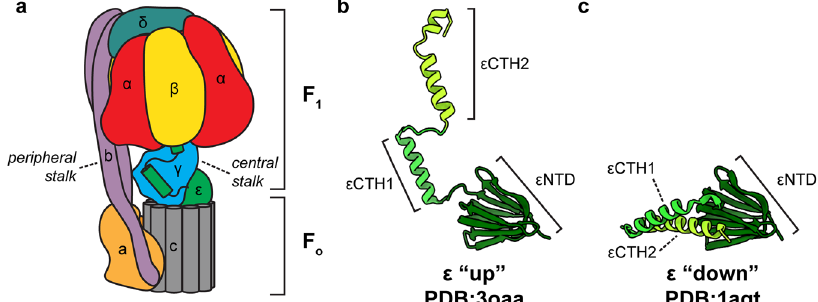
Fig. 1 The ε subunit of E. coli F 1 F o ATP synthase. a Schematic of E. coli F 1 F o ATP synthase with subunits colored and labeled. The ε subunit is shown in green in the inhibited up conformation. b Crystal structure of the ε subunit in the up conformation (PDB:3oaa 16 ), with α , β , and γ subunits removed for clarity. c Crystal structure of the isolated ε subunit in the down conformation (PDB:1aqt 20